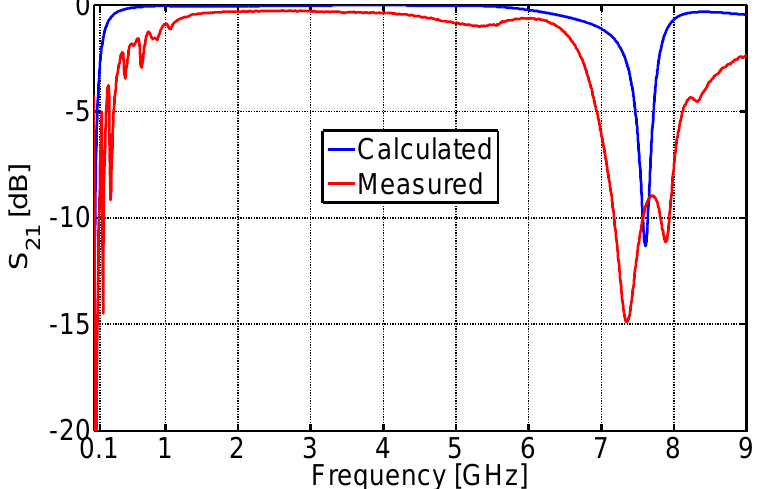
Figure 17. Calculated and measured transmission coefficient ( S 21 ) of the adiabatic transmission line .